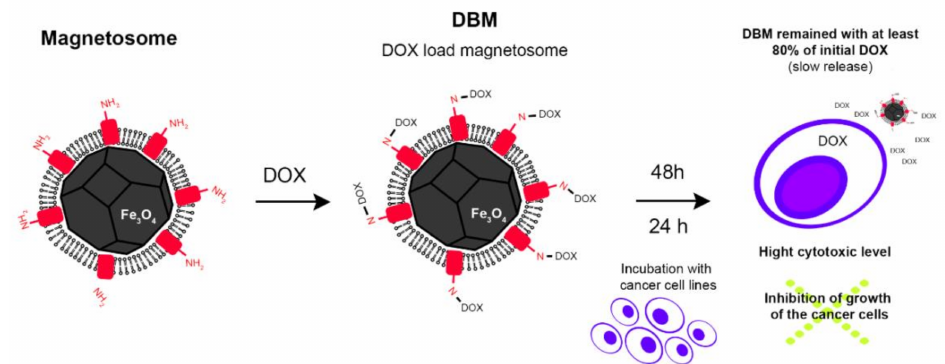
Figure 7. Illustrative scheme of the functionalization of magnetosome from Ms. gryphyswaldense strain MSR-1 with doxorubicin (DOX) binding to the amino groups of magnetosome proteins (red rectangles) inserted into the membrane of magnetosomes, forming DBM (DOX loaded magnetosomes). After treatment with DBM, cancer cells were inhibited from growing and the use of DBM resulted in a slow release of DOX. This indicates that the DBM complex is not degraded during systemic circulation and possesses potent antitumor activity